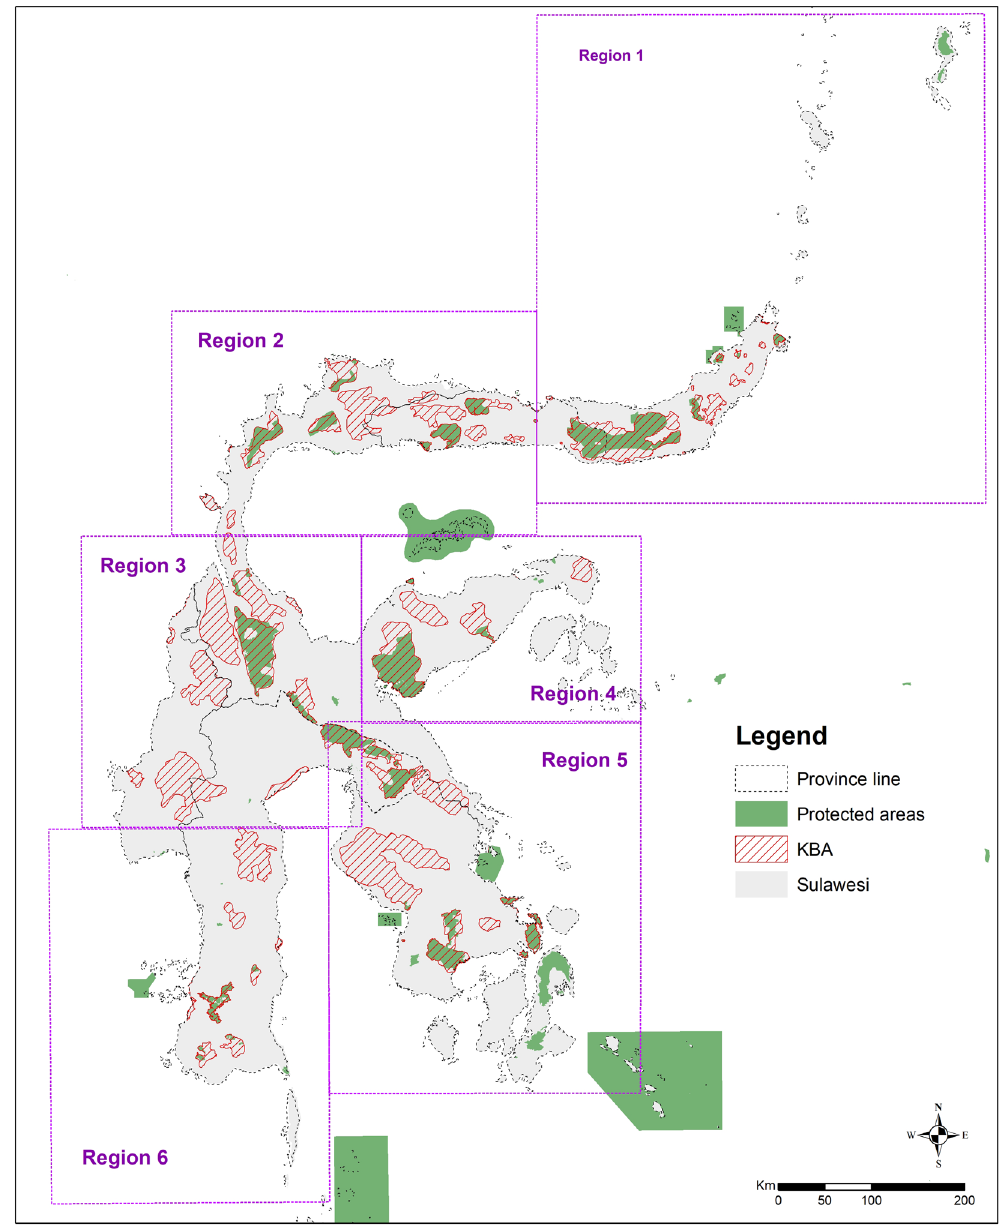
Figure 2. Geographic regions we used to define and identify new priority areas in Sulawesi.